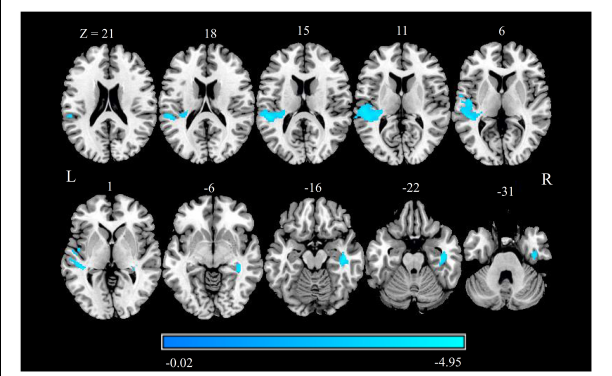
FIGURE 1 | GMV alterations in patients with CTN. Differences between the patients with CTN and HCs were analyzed using a two-sample t -test. The statistical significance level was set at p < 0.05, FDR corrected. Patients with CTN showed significantly increased GMV in the right hippocampus, right FFG, right ITG, left STG, left operculo-insular gyrus, and left MTG. The color bar displayed t -values. GMV, gray matter volume; CTN, classic trigeminal neuralgia; HC, healthy control; FFG, fusiform gyrus; ITG, inferior temporal gyrus; STG, superior temporal gyrus; MTG, middle temporal gyrus.